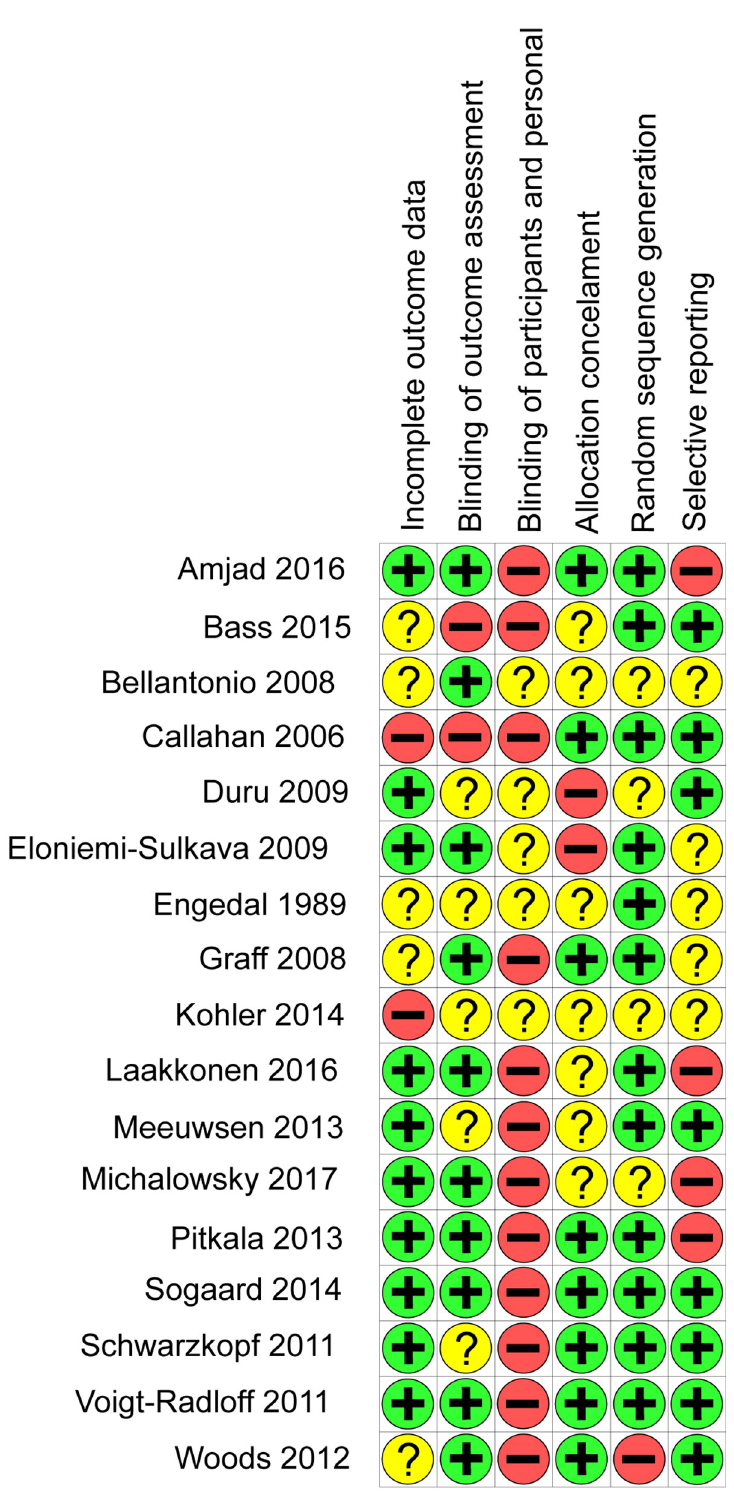
Fig 2. Result of risk of bias assessment. + = Low risk of bias,– = High risk of Bias, ? = Unknown risk of bias.